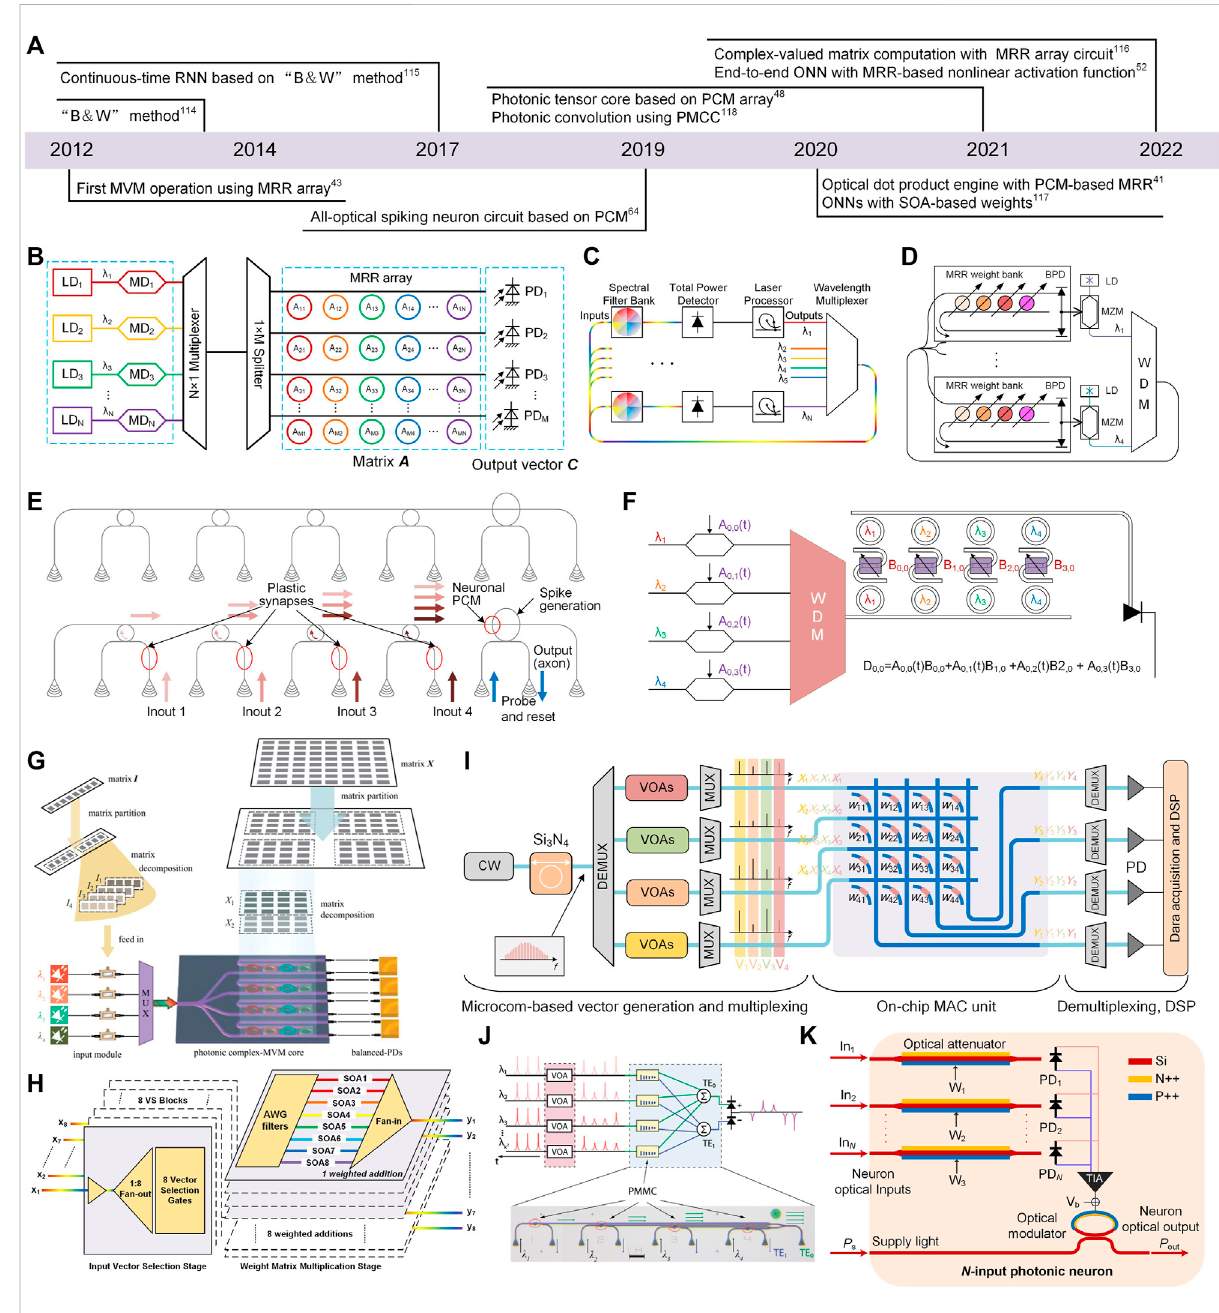
FIGURE 3 (A) The progresses of analog optical computing in the incoherent integration platform. (B) Schematic of MRR-based optical matrix-vector multiplier [43]. (C) Schematic of an optical B&W network [114]. (D) An experimental setup concept of B&W network [115]. (E) Schematic of the all- opticalspikingneuralcircuit[64]. (F) Schematicofthedot-productenginebasedonMRR[41]. (G) TheprincipleofMRR-basedcomplex-valued MVM [116]. (H) SchematicoftheSOAbasedweightedadditionoperationcircuits[117]. (I) Schematicofthephotonictensorcore[48]. (J) Schematicof theconvolutional photonic computing core using PMCC array [118]. (K) The schematic ofan N-inputphotonic neuronin theintegrated end-to-end photonic deep neural network chip [52]. (G) Reprinted from Ref. 116with permission from Springer: Frontiers of Optoelectronics. (J) Reprinted from Ref. 118 with permission from Springer Nature: Nature